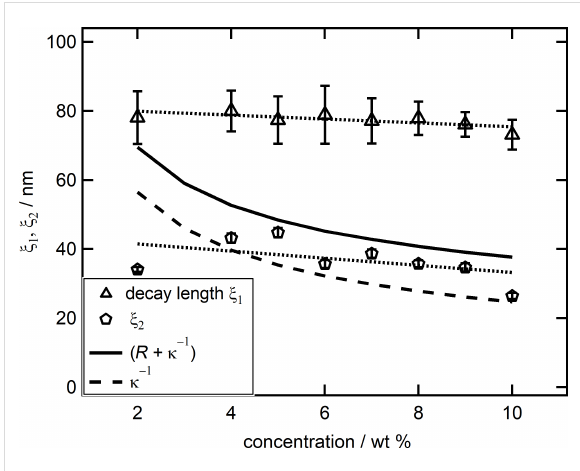
Figure 9: Decay length ξ 1 (triangles) together with ξ 2 (pentagons) in nm as a function of the suspension concentration in wt % together with linear trends (dotted lines). Also shown are the Debye length κ − 1 (dashed line) and the sum of Debye length and particle radius κ − 1 + R (solid line).